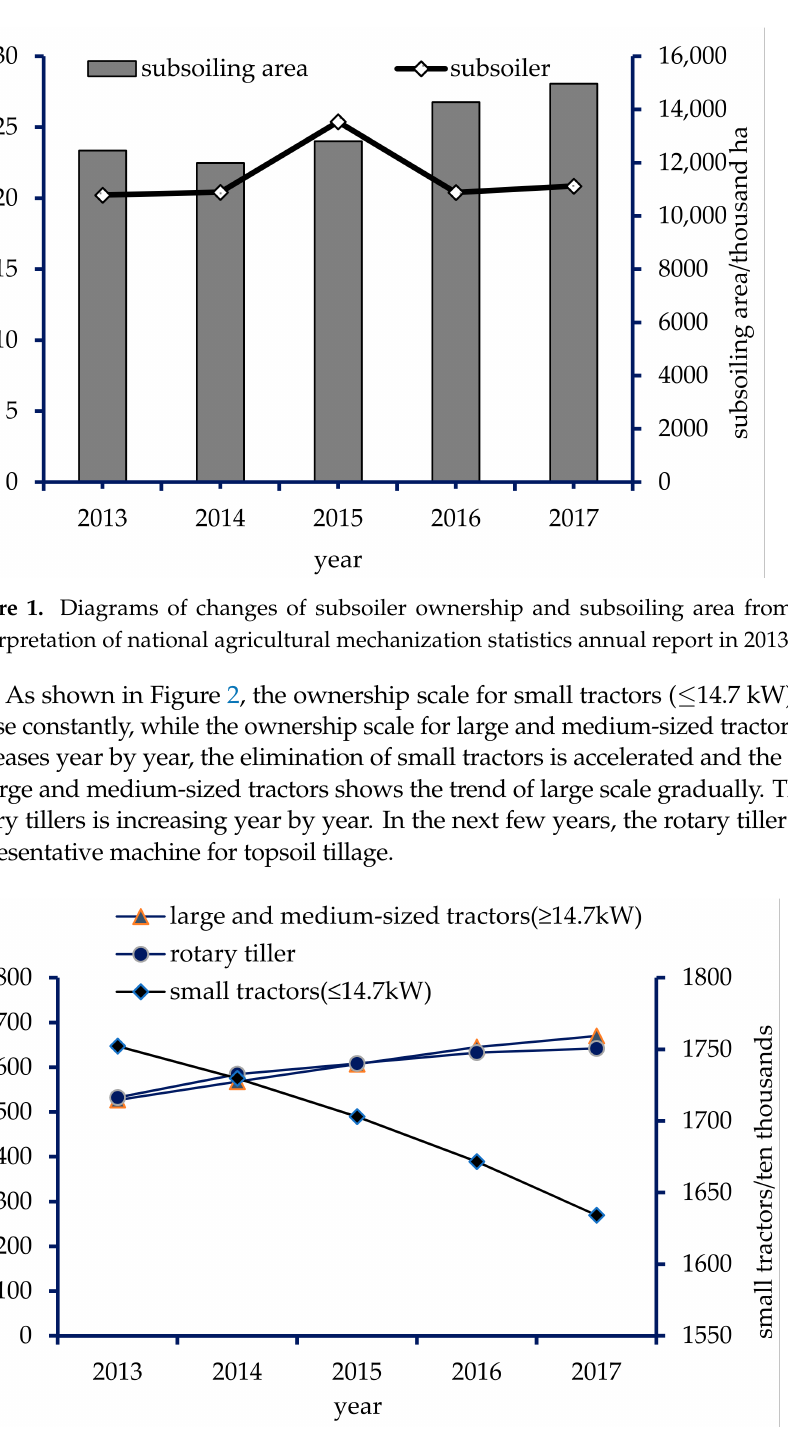
Figure 2. Diagrams of changes in the ownership of small, large and medium-sized tractors and rotary tillers (Interpretation of national agricultural mechanization statistics annual report in